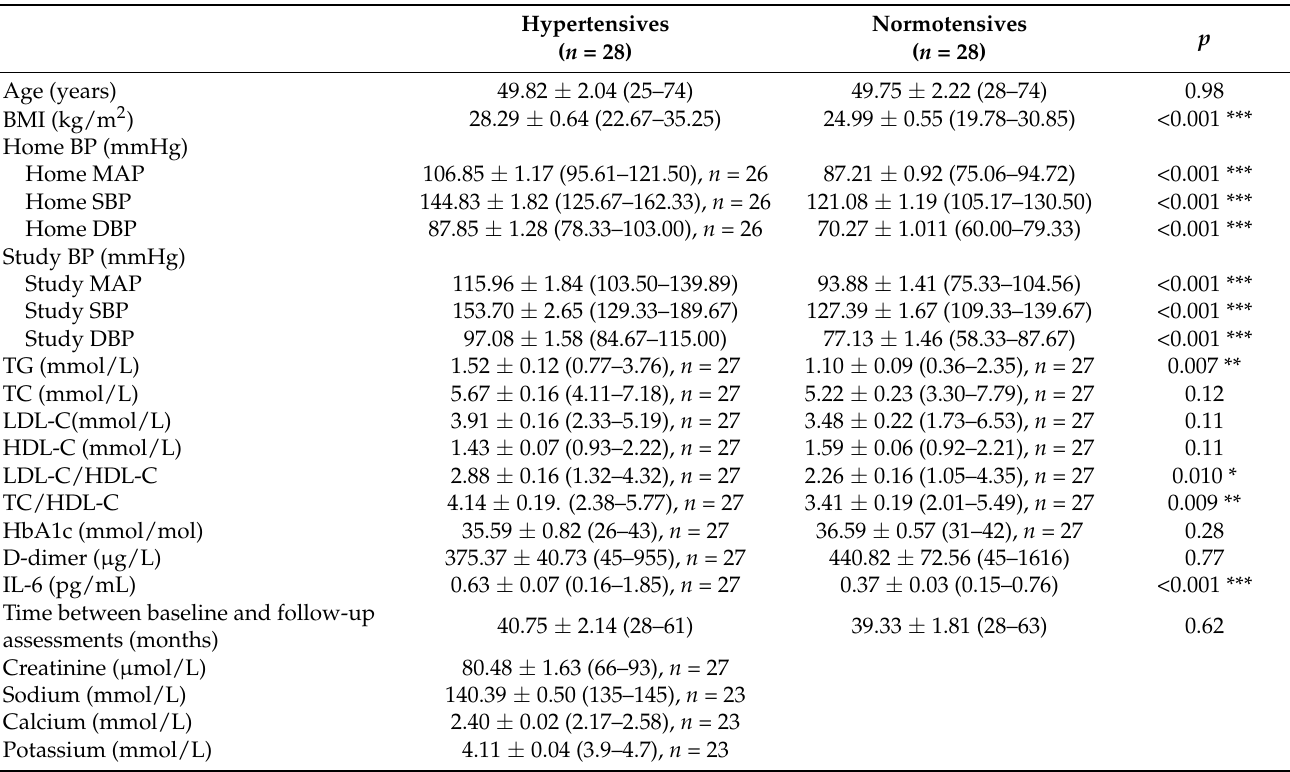
Table 1. Comparison of baseline group characteristics between hypertensive and normotensive